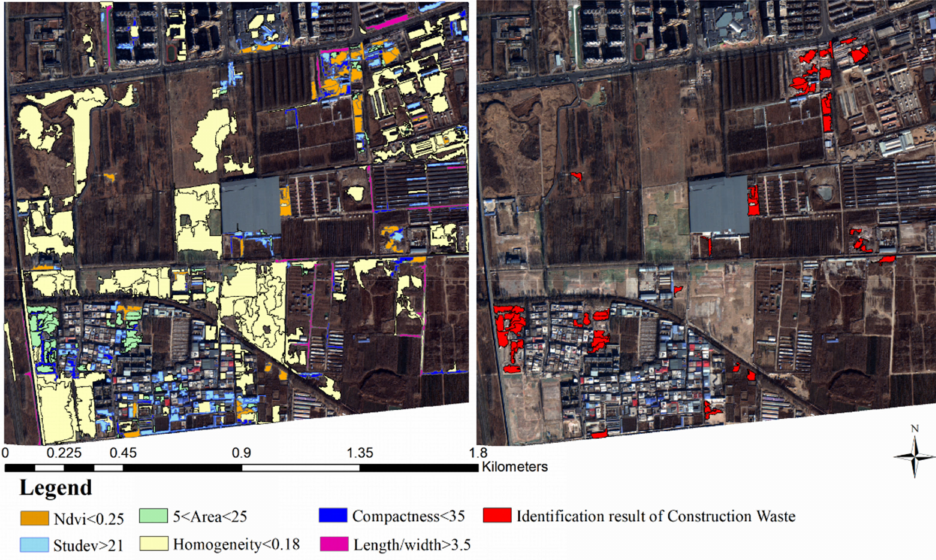
Figure 16. Construction waste extraction results in study area